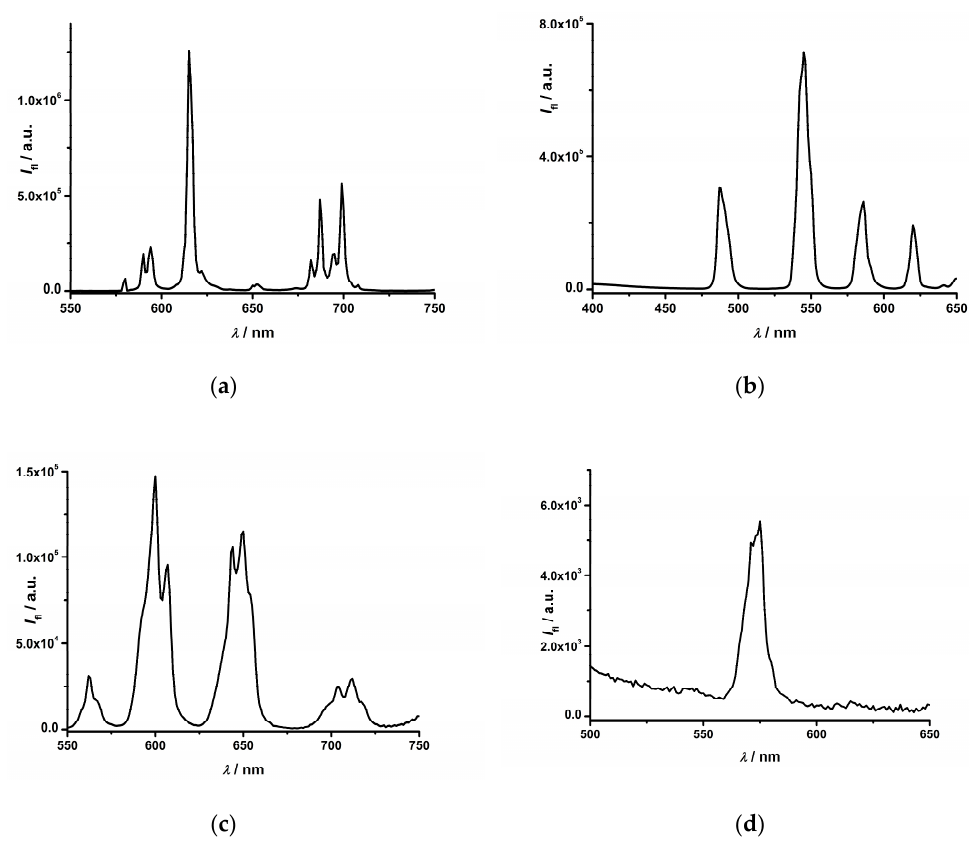
Figure 2. The antenna effect of ternary Eu(III) ( a ), Tb(III) ( b ), Sm(III) ( c ) and Dy(III) ( d ) complexes with DO3A macrocyclic and IQCA ligands ( λ exc = 325 nm, pH = 7.5 (40 mM HEPES), c Ln ~ 0.2 mM, c DO3A ~ 0.3 mM, c IQCA ~ 0.35 mM).